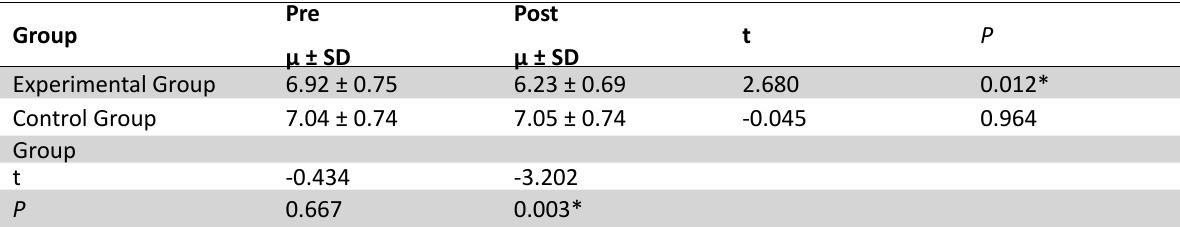
Table 5. The Comparison of Pretest and Posttest Between and Within Control Group and Experimental Group in L-Run Score after Six Weeks with CoBAgi Training